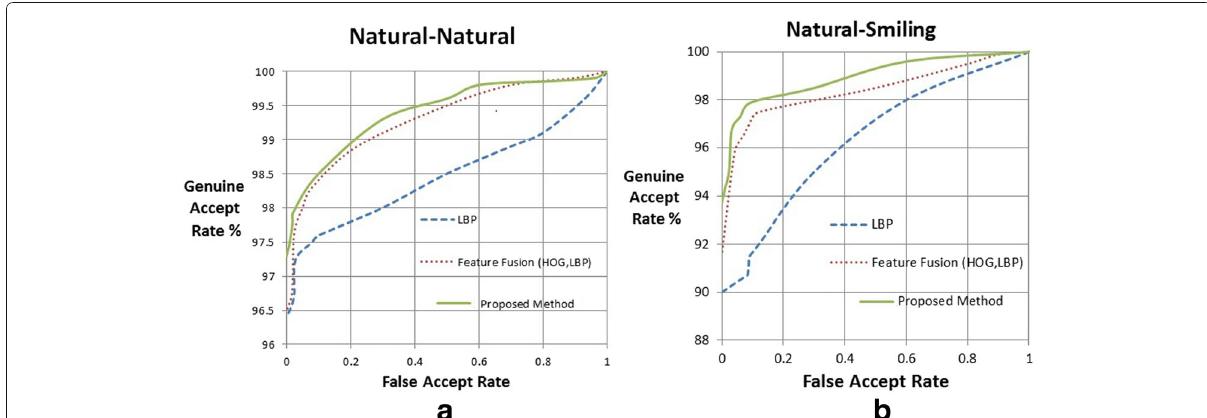
Fig. 5 ROC curves for a natural-natural expression/ b natural-smiling expression